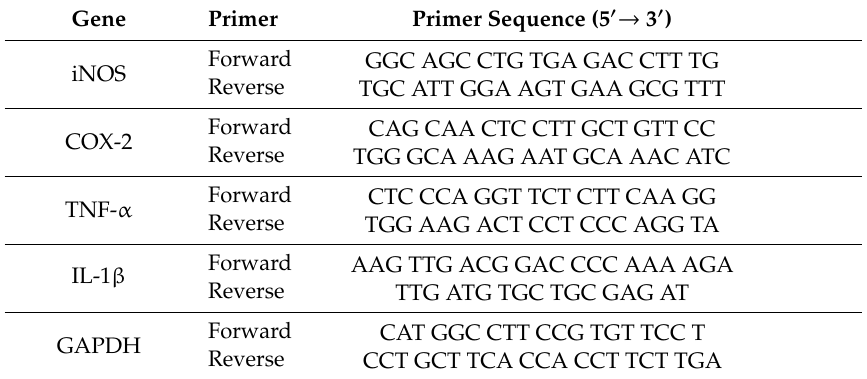
Table 1. Gene sequence